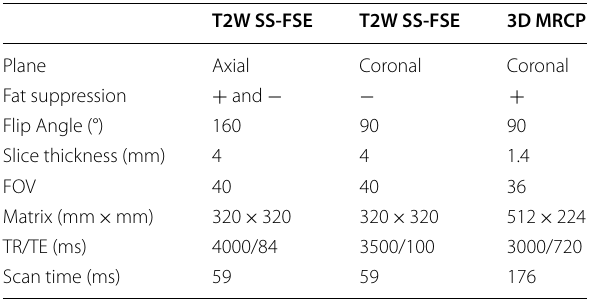
Table 1 MRCP protocol and sequences used for the current